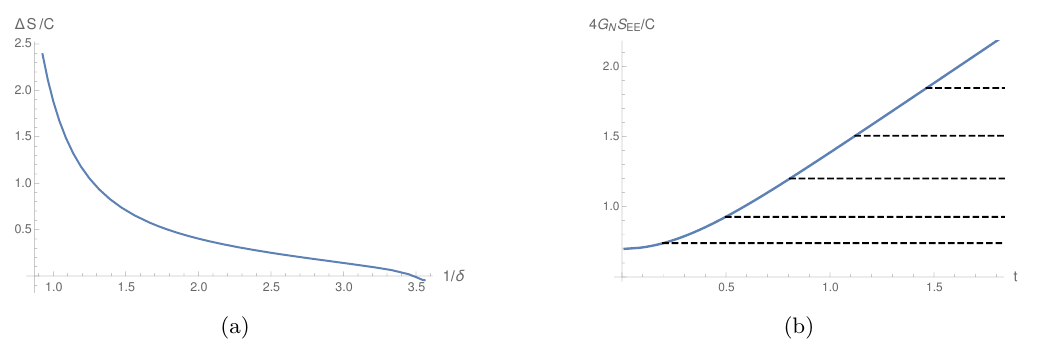
Figure 12 . Left: area differences ∆ S = S island − S HM normalized to the constant in (6.3). The plot shows the extrapolated curve of figure 11(b). Right: Page curves. The solid line shows the time-dependent finite part of the area of the HM surface. The corresponding constant areas of island surfaces are shown as dashed lines, from bottom to top for δ ∈ { 0 . 29 , 0 . 32 , 0 . 4 , 0 . 5 , 0 . 6 } . The Page time increases monotonically with δ